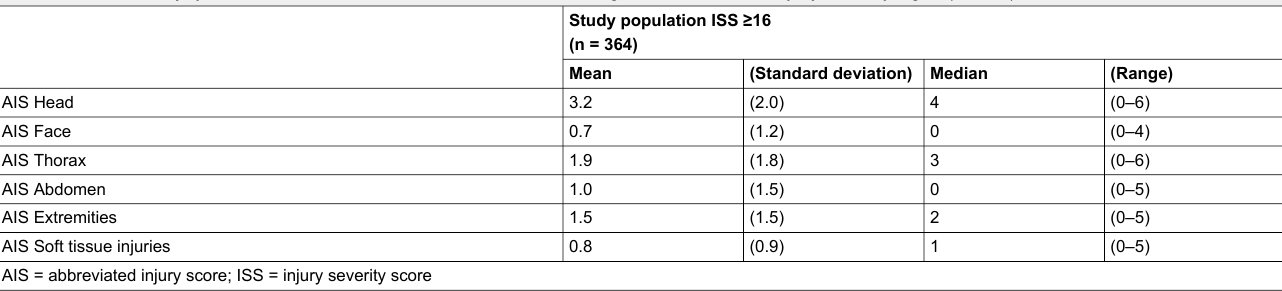
Table 2: Abbreviated injury score distribution of cases with severe trauma discharged in 2011 and 2012 by injured body region (n = 364).